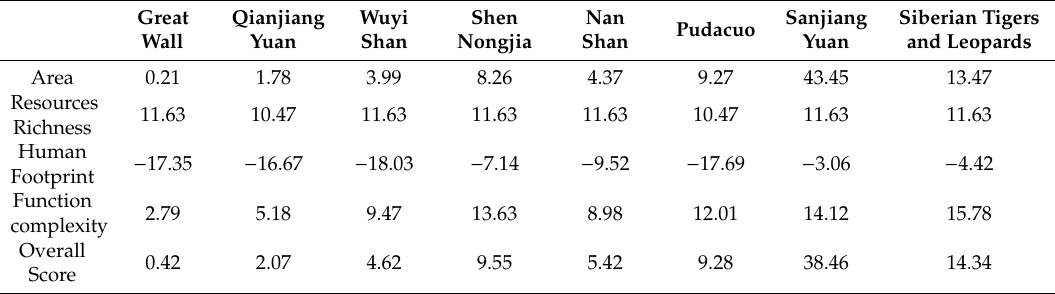
Table 5. Comprehensive index of eight pilot national parks in